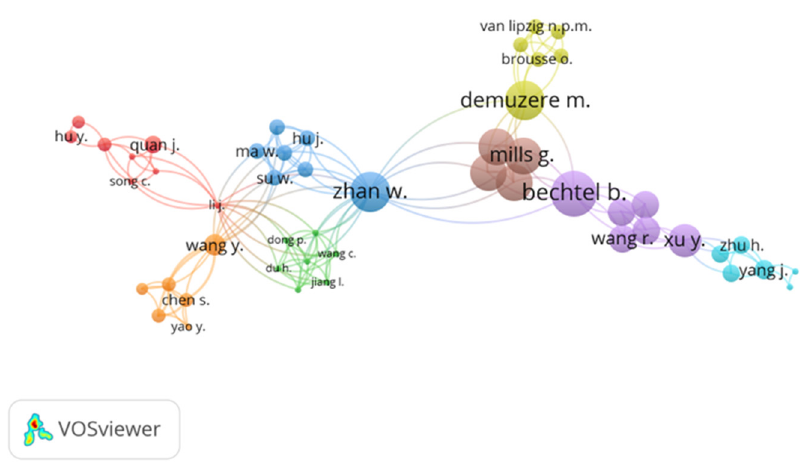
Figure 4. Authors’ maps by citation.